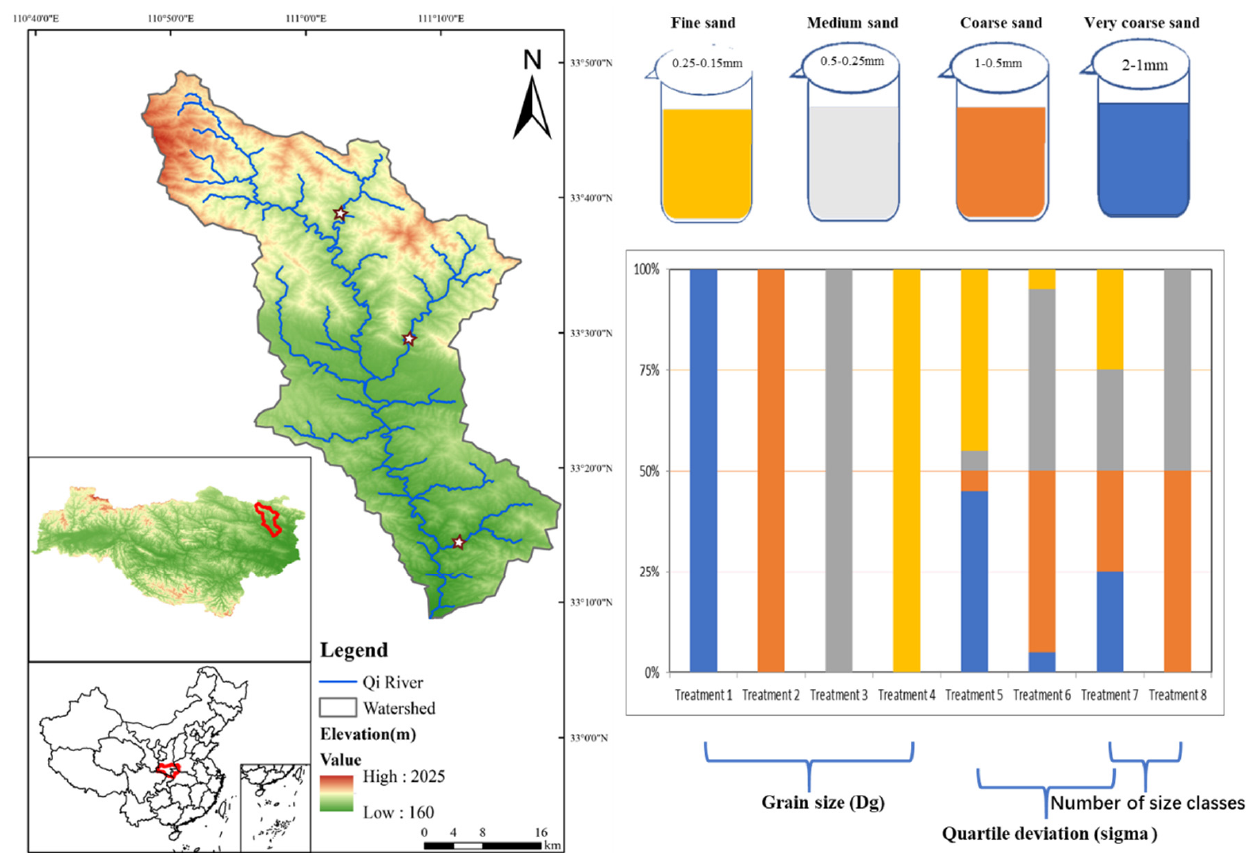
Figure 1. Location of the three reaches (red hollow stars) within the Qi River located on the Danjiangkou reservoir basin in central China ( left panel ) and eight treatment designs ( right panel ).